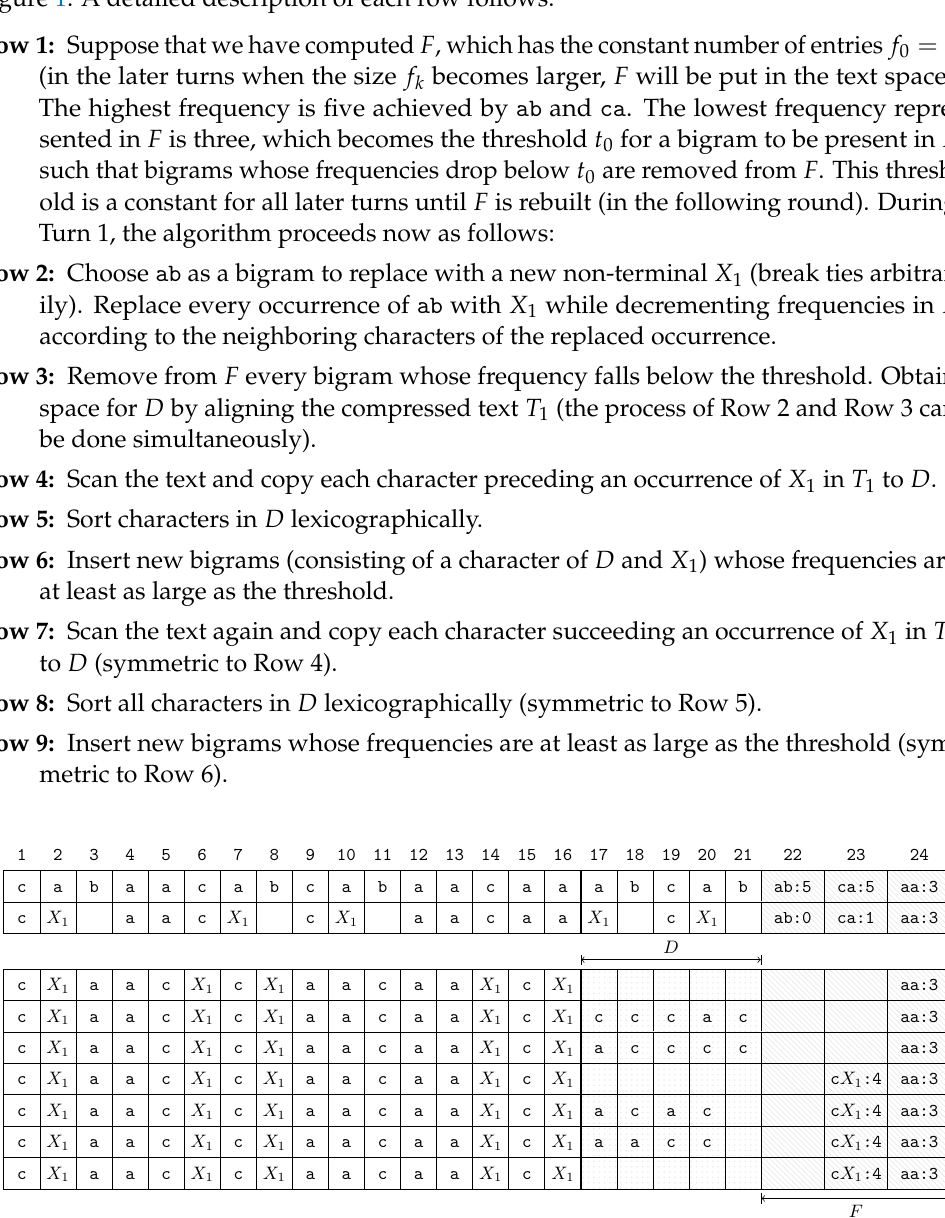
Figure 1. Step-by-step execution of the first turn of our algorithm on the string T = cabaacabcabaacaaabcab . The turn starts with the memory configuration given in Row 1. Posi- tions 1 to 21 are text positions, and Positions 22 to 24 belong to F ( f 0 = 3, and it is assumed that a frequency fits into a text entry). Subsequent rows depict the memory configuration during Turn 1. A comment on each row is given in Section